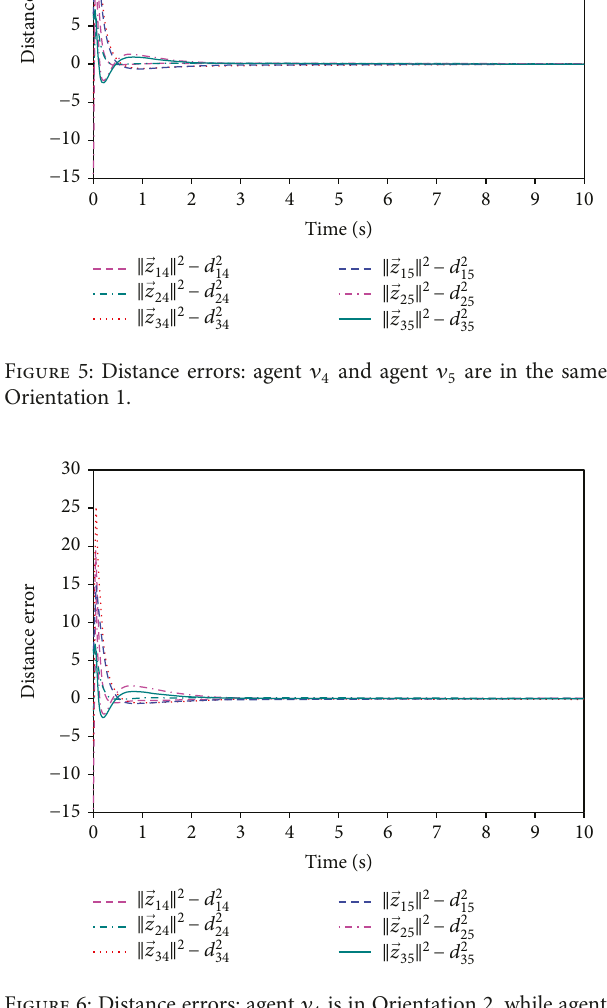
4 is in Orientation 2, while agent